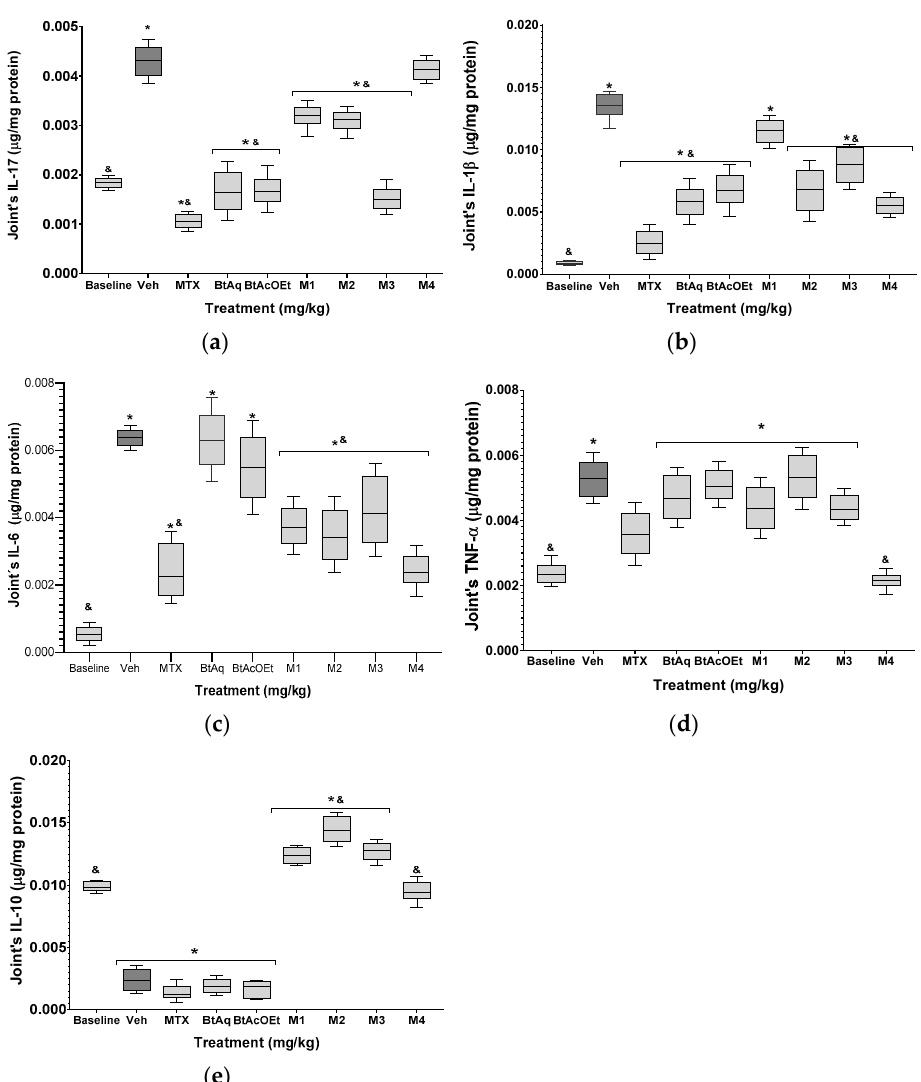
Figure 5. Effect of different experimental treatments obtained from B. ternifolia extracts on the inflammatory response ( a ) IL-17, ( b ) IL-1 β , ( c ) IL-6, ( d ) TNF- α and ( e ) IL-10, of the patellofemoral joint of mice with experimental arthritis, compared to negative control Vehicle ( & ) and Basal con- trol (*) groups. The aqueous extract BtAq and the ethyl acetate extract, BtAcOEt, were derived from the bipartition of the complete extract. Fractions M1, M2, M3, and M4 were obtained from BtAcOEt. ANOVA with post hoc Tukey tests with * p < 0.05 compared with baseline group, & p < 0.05 compared with Veh group (n = 7 ± SD).